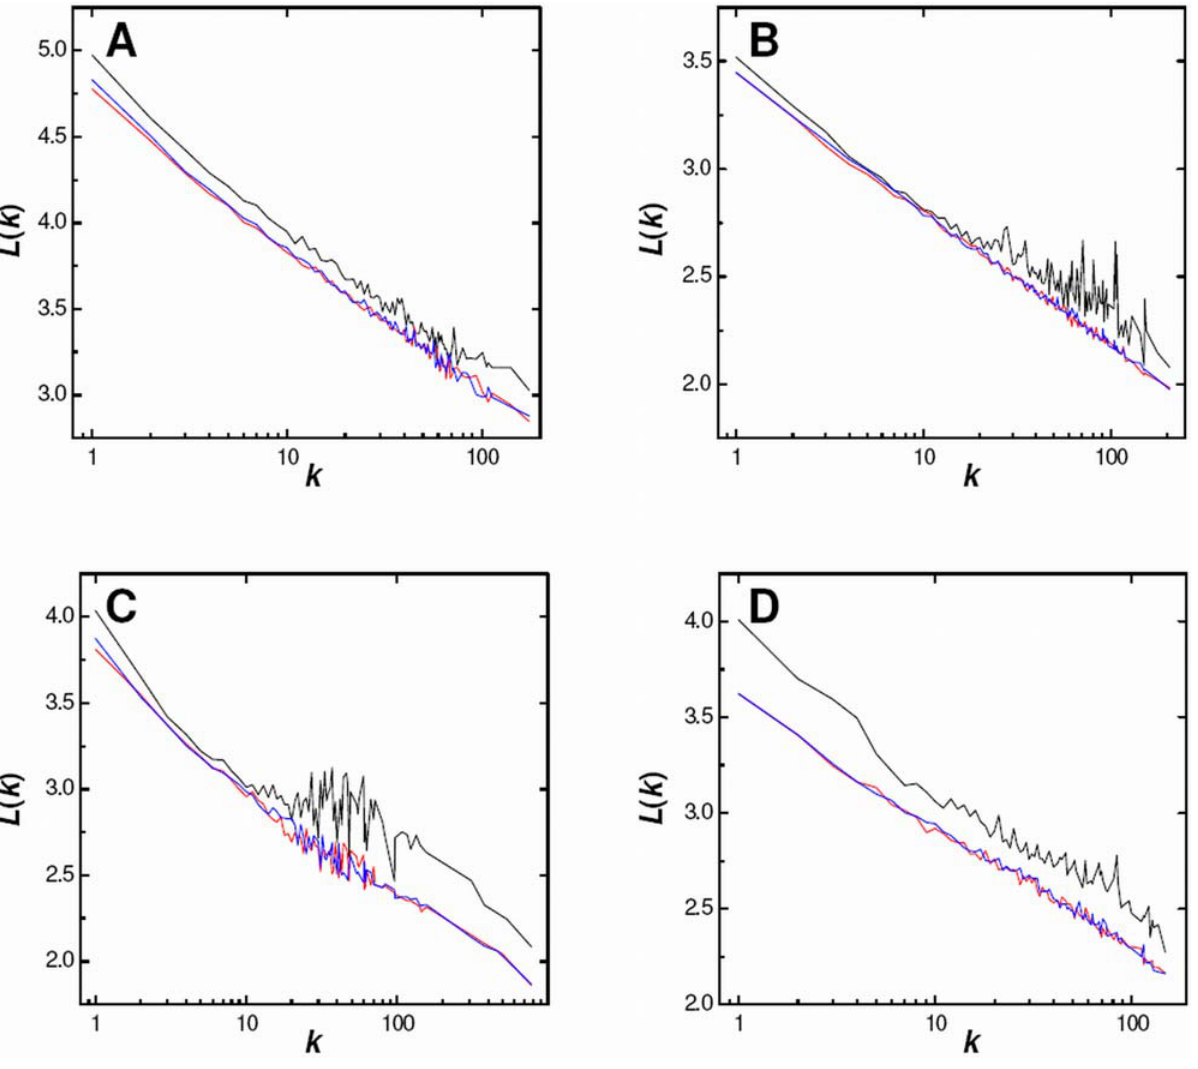
Figure 5. Dependence of Path Length upon Node Degree for Four PPI Networks and their DCDW Equivalents. (A) Drosophila melanogaster , (B) Campylobacter jejuni , (C) Escherichia coli ( HT2 ), and (D) Escherichia coli ( HT1 ). Path length profiles for the PPI networks (black) and the corresponding tenth (blue) and fiftieth (red) realizations of the DCDW model.